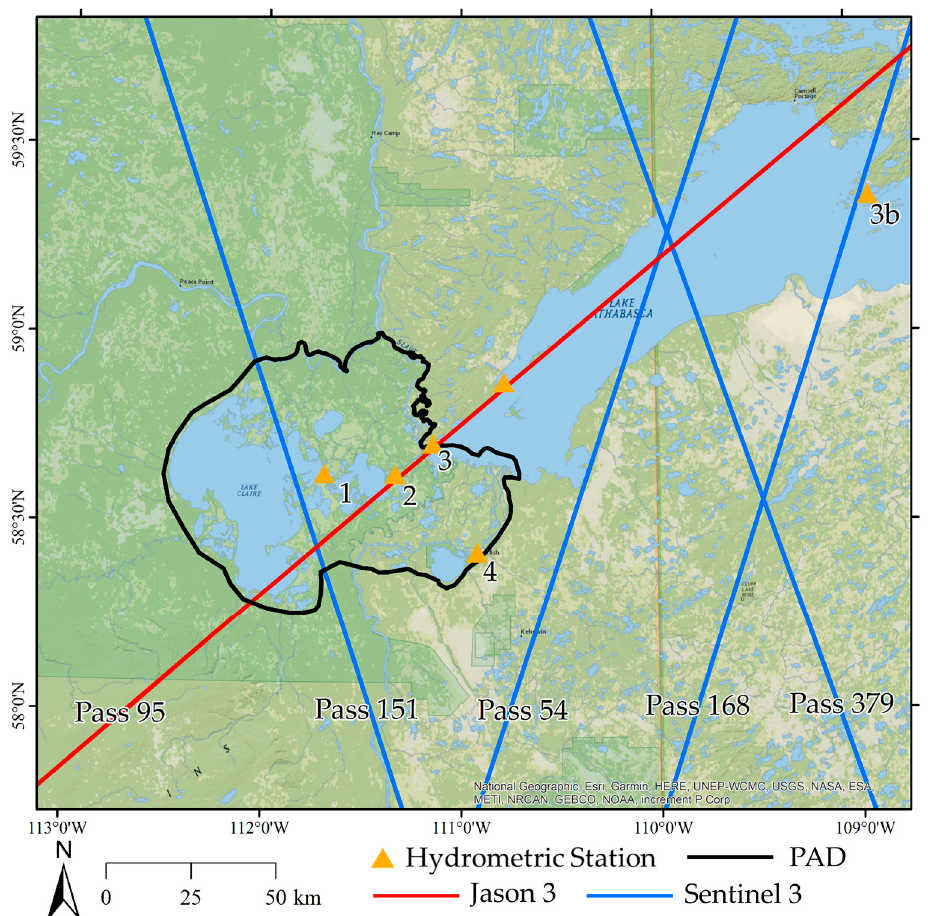
Figure 5. Study period altimetric instrument passes over the PAD (black outline) See Figure 1 for names of hydrometric stations 1 to 4. Table 3. Numbers of images capturing water level of the four major lakes, as well as Baril Lake, during the 2020 flood event (May to October).